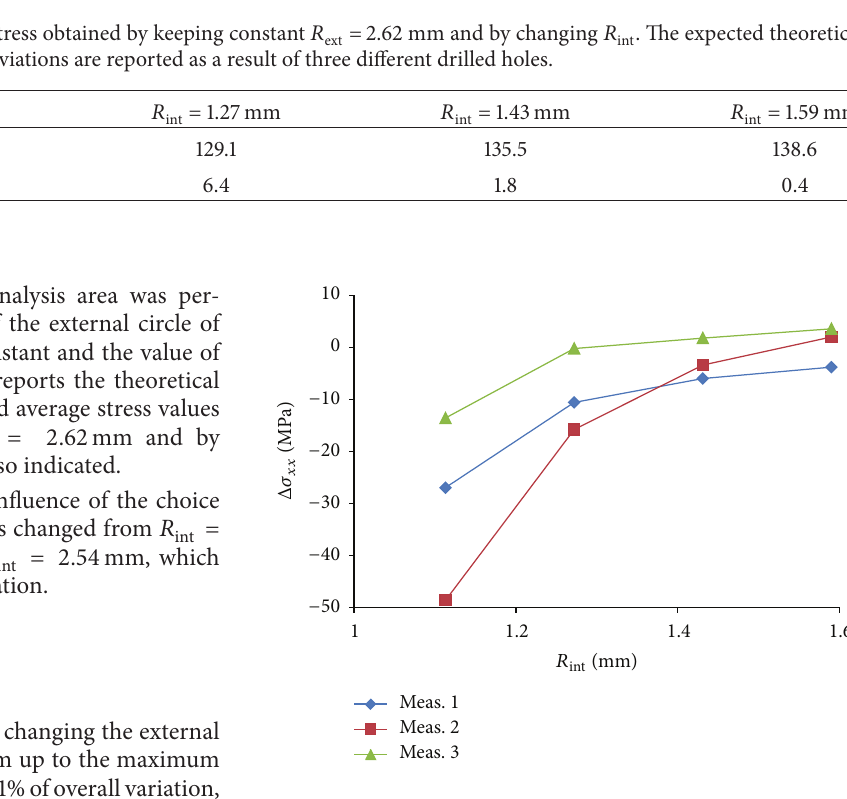
Figure 5: Plot of the average stress measured along the drilled depth in correspondence with different values 𝑅 int and by keeping constant = 2.62 mm. The three the value of the external radius ratio 𝑅 ext curves refer to three different holes in the same specimen under the same stress